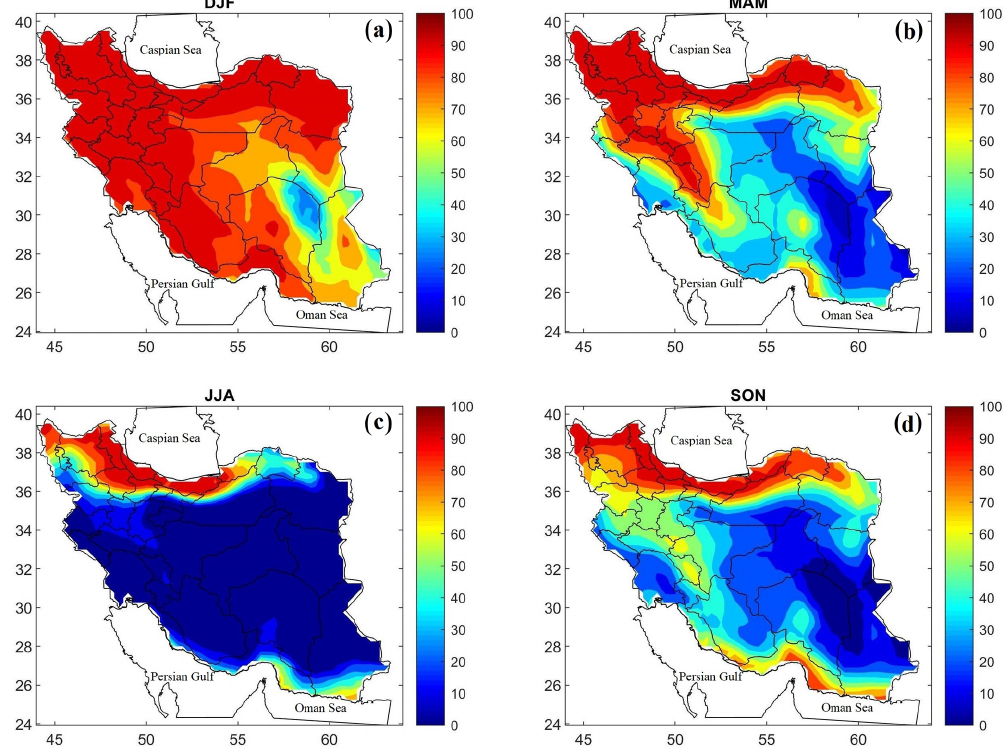
Figure 3. Frequency of dew occurrence as a fraction of the days presented as an overall seasonal mean during 1979–2018. (a) Winter (December, January, and February), (b) spring (March, April, and May), (c) summer (June, July, and August), and (d) autumn (September, October, and